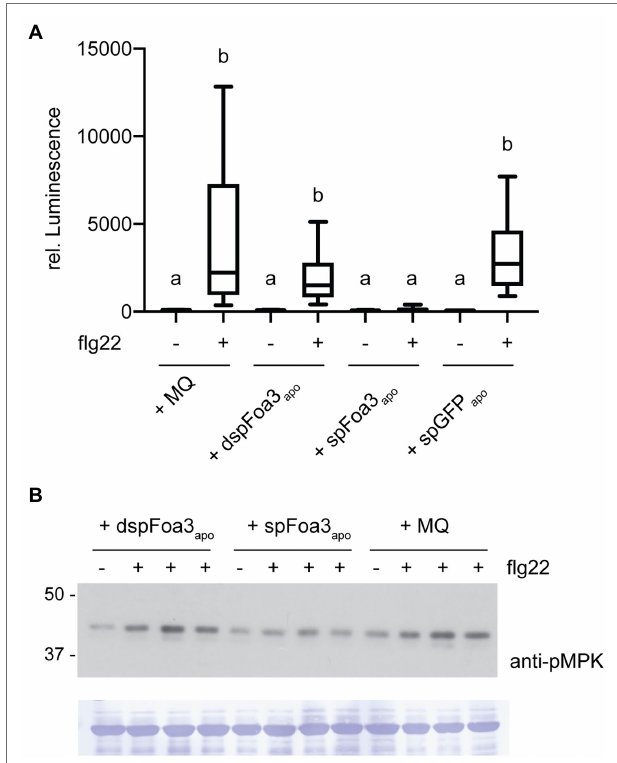
FIGURE 4 | Infiltration of Foa3-containing apopastic fluid into Nicotiana benthamiana leaves results in suppression of flg22-triggered defense responses. (A) Flg22-triggered ROS burst in Nicotiana benthamiana leaves that were treated as follows: Infiltrated with water (MQ), infiltrated with apoplastic fluid isolated from Nicotiana benthamiana plants expressing either dspFoa3-GFP (dspFoa3-GFP apo ) or SPpr1-Foa3-GFP (SPpr1-Foa3-GFP apo ) or SPpr1-GFP (SPpr1-GFP apo ), respectively. Boxes extend from the 25 th to the 75 th percentile, whiskers from the lowest to highest values, bar indicates the median, n = 16 leaf discs. Significant differences are indicated ( p < 0.05, Kruskal-Wallace test). (B) Western blot showing flg22-triggered activation of MAP kinases in Nicotiana benthamiana leaves infiltrated with water (MQ) or apoplastic fluid isolated from Nicotiana benthamiana plants expressing either dspFoa3-GFP (dspFoa3-GFP apo ) or SPpr1-Foa3-GFP (SPpr1-Foa3-GFP apo ). Subsequently, leaves were treated with water ( − ) or flg22 (+) for 10 min. Three independent flg22-treated samples were loaded on blots next to each other. Molecular weight (kDa) markers are shown on the left. Equal loading is verified by Coomassie staining of the blots. Experiments were repeated three times with similar